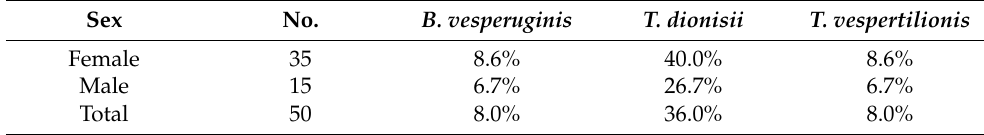
Table 1. Total PCR-based prevalence of blood parasites and prevalence in males and females.